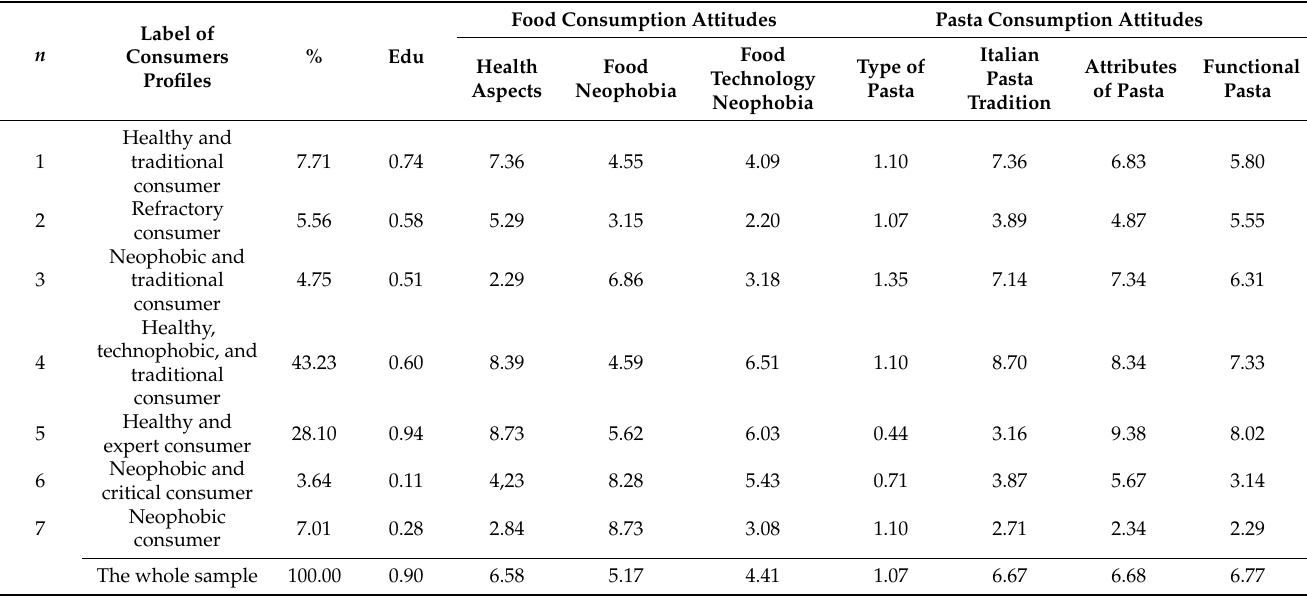
Table 6. Profiles of consumers segments ( n = 328) with mean scores of variables within the